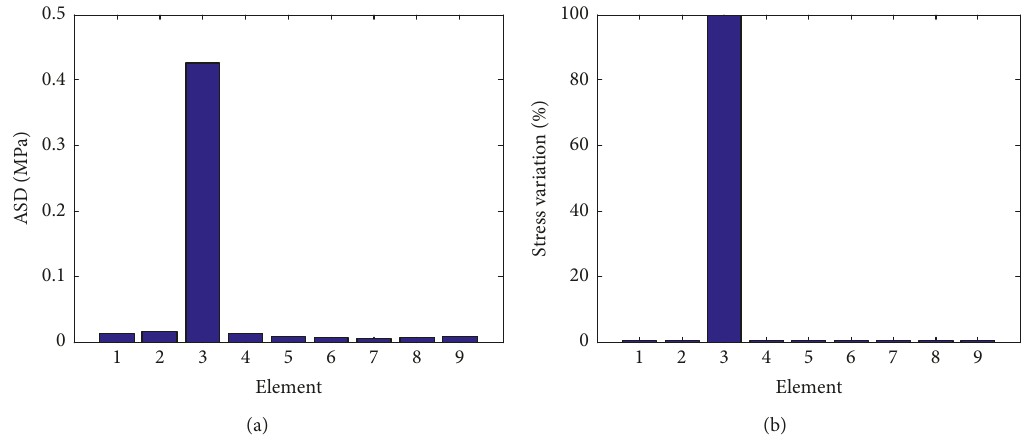
Figure 6: A single damage at element ③ using 5% noise-contaminated measurements and the disassembling-based approach of (a) ASD and (b) stress variation